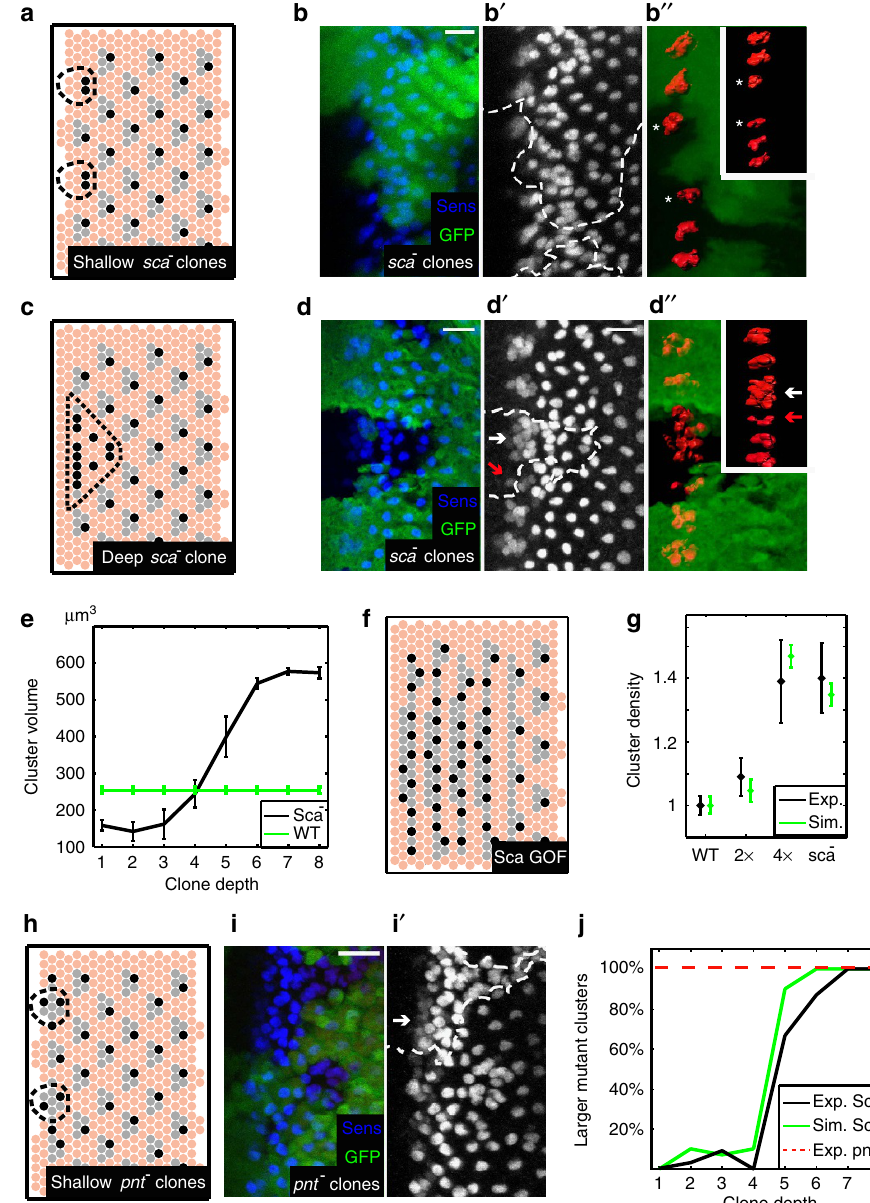
Figure 5 | Clonal analysis supports Sca role as activator of ato expression. ( a ) Simulations of shallow clones (enclosed by broken line) result in smaller clusters. In grey are cluster cells that were inhibited by the selected cells in each cluster (in black). ( b ) The nuclei stained for Sens are in blue, and shallow clones that lack sca are visualized by lack of GFP signal in green indicated by the white broken line. In the right panel ( b 00 ), clusters are marked in 3D in red using the Imaris imaging software that quantifies the volume of each cluster. White asterisks indicate smaller clusters inside the clones. Between the indicated clusters there is a gap where no cluster has formed. Inset shows the clusters after 90 (cid:2) rotation. Scale bar, 10 m m. ( c , d ) Same as a , b , but for a deep clone. White arrows in d indicate a larger cluster, while red arrows indicate a smaller cluster in the shallow region of the clone. Scale bar, 10 m m. ( e ) Shown are the average cluster sizes within sca mutant clones as a function of clone depth. Clusters larger than 600 m m 3 where not included. Number of clones analysed are n ¼ 55,13,10,6,4,4,4,4 for clones of depth one to eight columns, respectively. Error bars denote s.e. ( f ) Simulation of Sca gain-of-function (GOF) discs. ( g ) Cluster density in sca (cid:3) / (cid:3) mutants and in sca gain-of-function flies carrying two or four (2 (cid:2) and 4 (cid:2) ) copies of roE-sca (an enhancer fragment of the rough gene that drives sca expression) was quantified in ref. 25 (black bars). Regions containing 17 or 18 clusters in at least four discs from each genotype were subjected to this quantitative analysis. Cluster density in our simulations was quantified by dividing the number of cells in the clusters by the number of total cells in 72 simulations for each genotype. Error bars denote s.e. ( h , i ) Same as a , b for clones depleted of pnt. ( j ) The percentage of larger sca (cid:3) / (cid:3) and pnt (cid:3) / (cid:3) mutant clusters as a function of clone depth. Number of sca (cid:3) / (cid:3) clones analysed is the same as in e . At least three pnt (cid:3) / (cid:3) clones were analysed for each